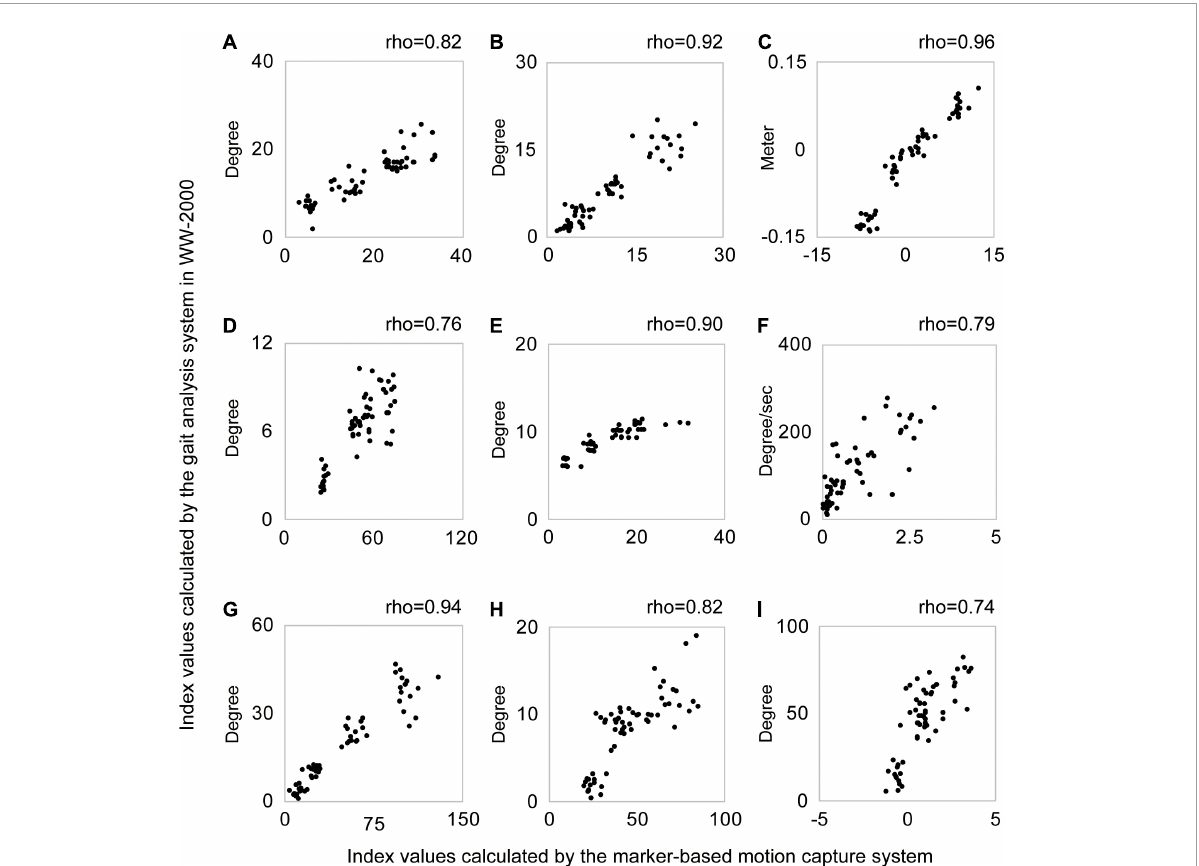
FIGURE3 Scatter plots of the index values calculated by the gait analysis system in the Welwalk WW-2000 and marker-based motion capture system for each abnormal gait pattern in a typical case. Each graph is a scatter plot for each abnormal gait pattern index value calculated using the two methods in a typical case. Each abnormal gait pattern in the graph was as follows: (A) hip hiking, (B) circumduction, (C) retropulsion of the hip, (D) excessive hip external rotation, (E) excessive lateral shift of the trunk over the unaffected side, (F) knee extensor thrust, (G) medial whip, (H) posterior trunk tilt, and (I) contralateral vaulting. A plot in the graph shows the index value of the abnormal gait pattern calculated by the two systems at one stride. The horizontal axis shows the index values of the abnormal gait pattern calculated by the marker-based motion capture system and the vertical axis shows the index values calculated by the gait analysis system in the Welwalk WW-2000. Spearman’s rank correlation coefficient value (rho) of each abnormal gait pattern is shown above the graph. In this case, the abnormal gait pattern index values calculated by both systems confirm positive correlations between the two